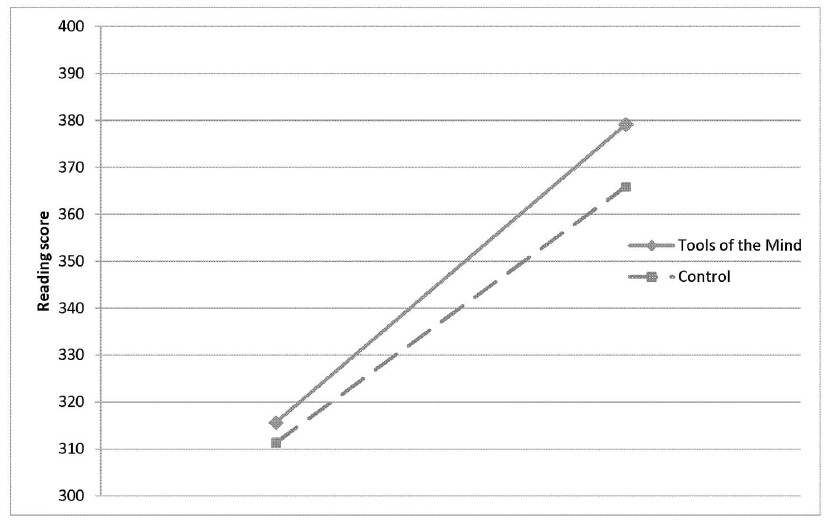
Figure 3. Effect of the Tools of the Mind curriculum on growth in reading (linear slope) from the beginning of kindergarten through the fall of first grade, b=2.24, se=.83, p=.001.